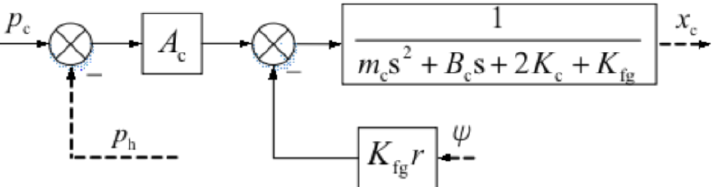
Figure 20. Control block diagram from buildup pressure to feedback stage spool displacement.